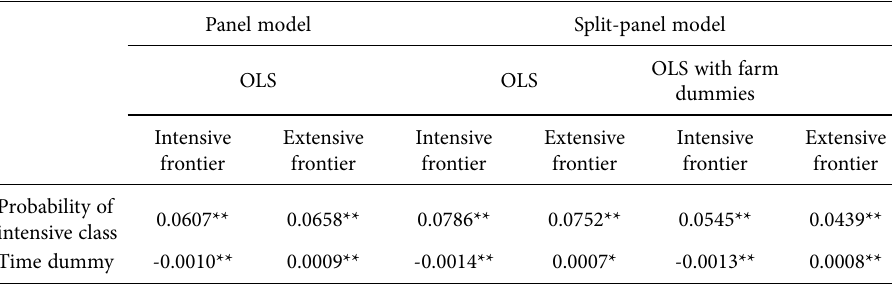
Table 9. Relationship between technical efficiency and